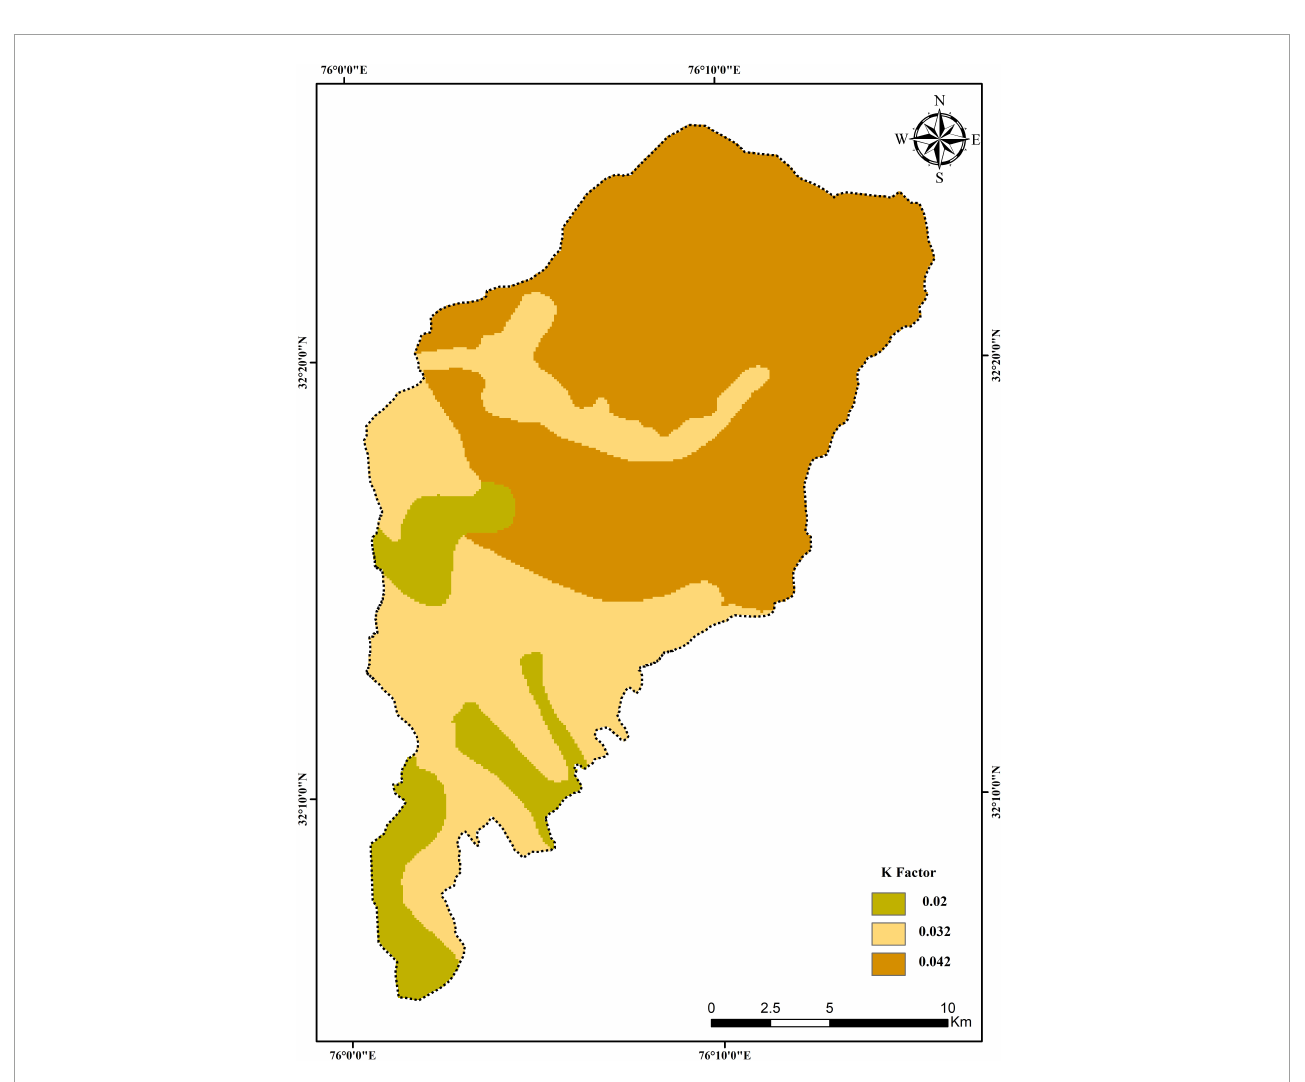
FIGURE10 Map showing K factor of the Dehar